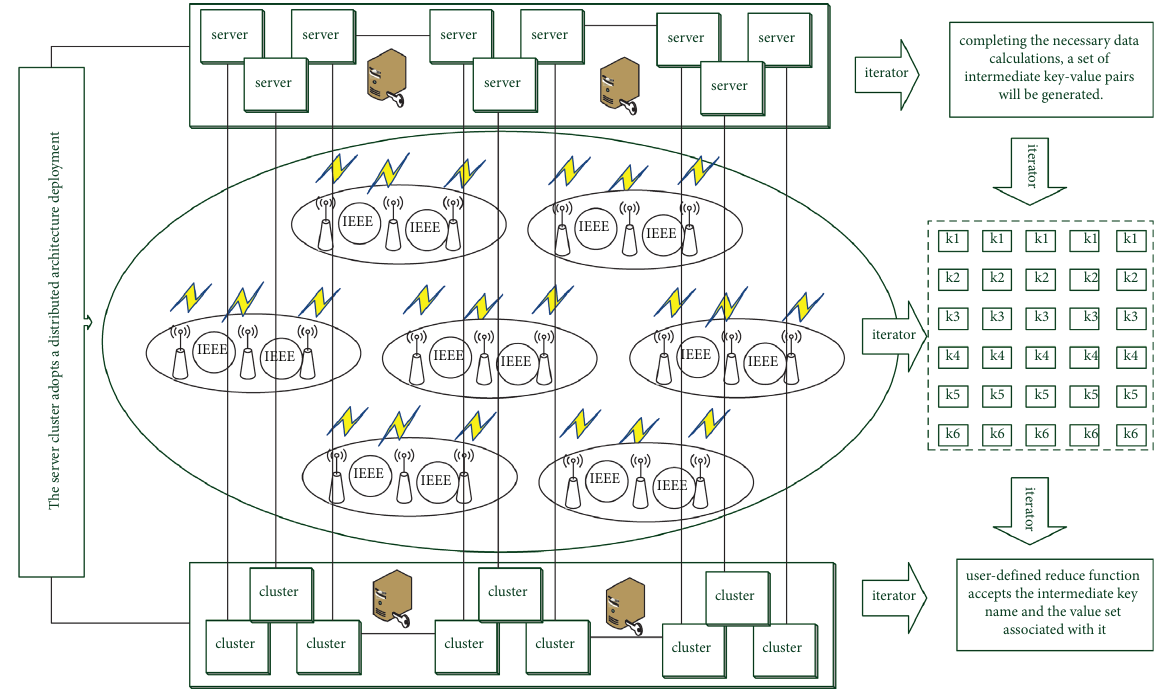
Figure 1: Hierarchical structure of big data